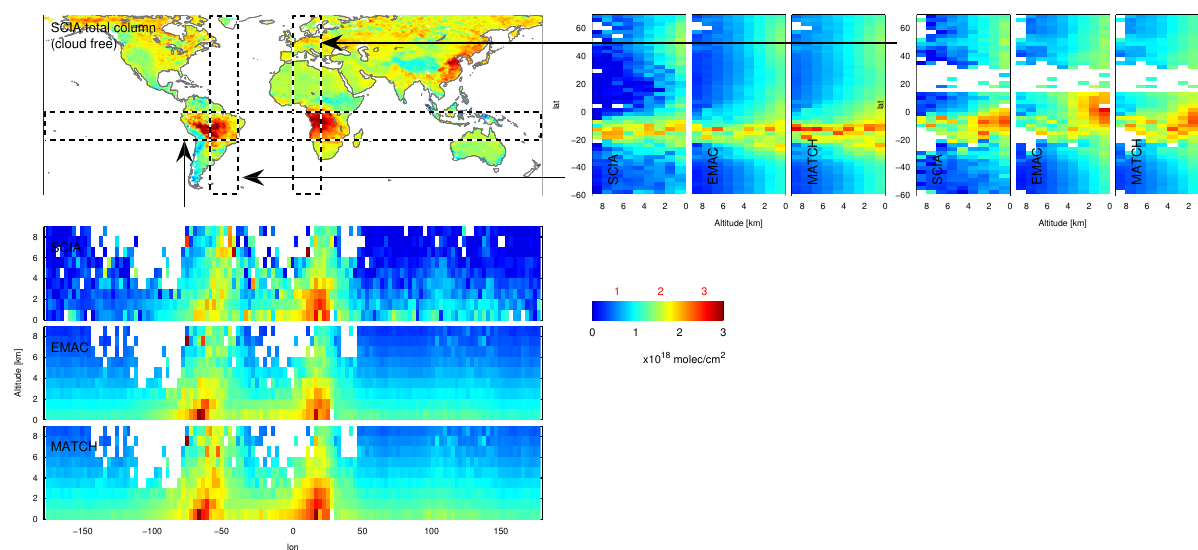
Fig. 13. Same as Fig. 11, but for July–September and for meridional and zonal cross sections over Africa and South